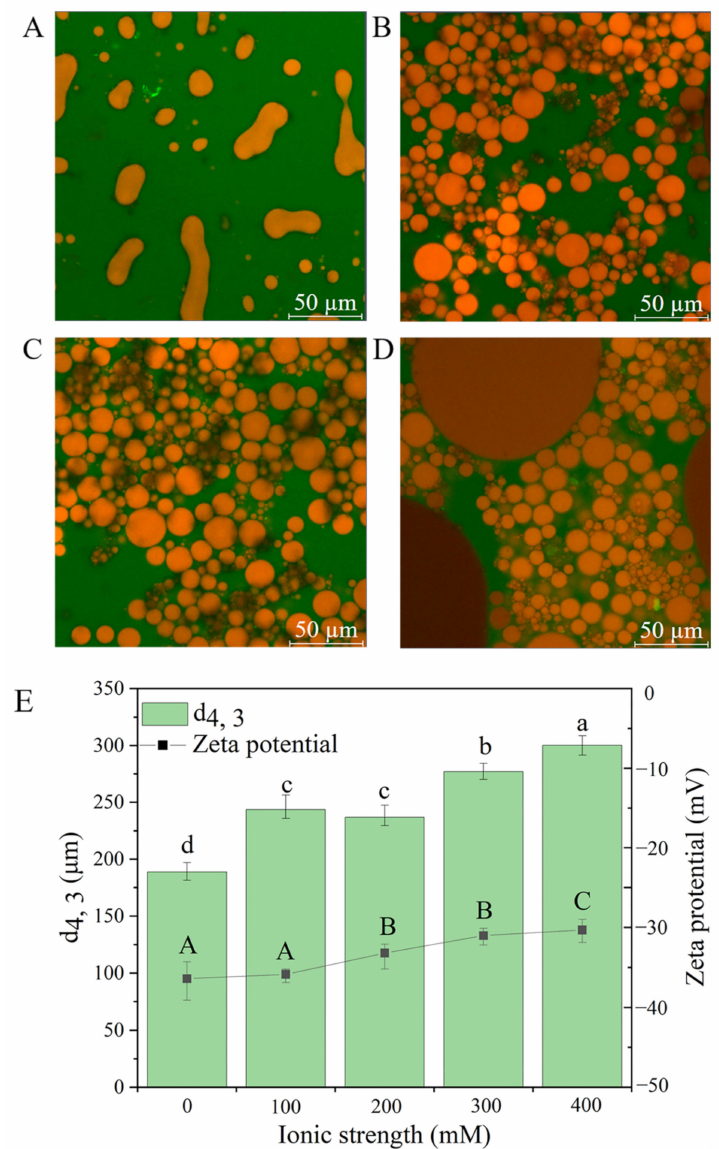
Figure 6. CLSM images ( A – D ) of the effect of different ion concentrations (100–400 mM) on